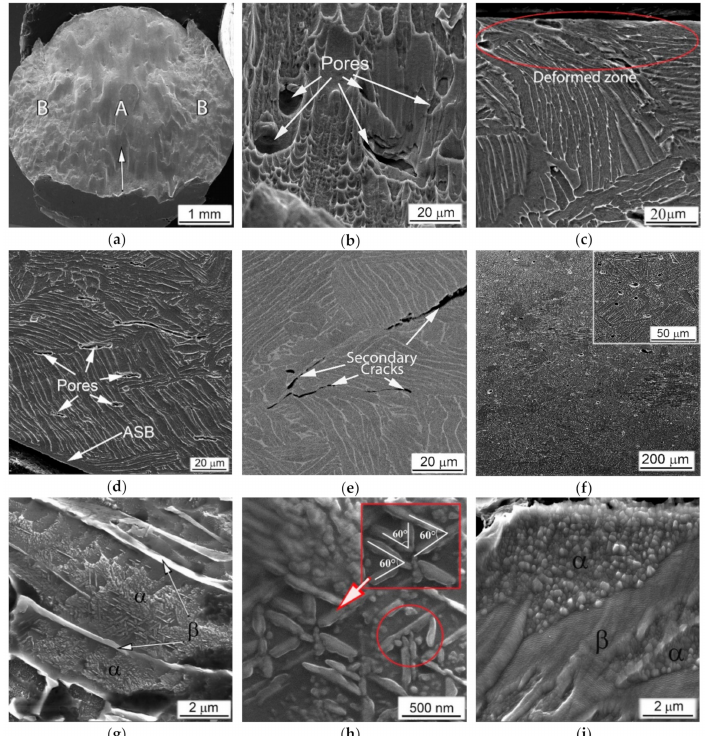
Figure 18. The SEM images of the fracture surface of the Ti64BEPM specimen tested at the strain rate of 2220 s − 1 : ( a ); general view; ( b ) residual pores at fracture surface; ( c – i ) internal microstructure; ( c ) zone I, ( d ) zone II; ( e , f ) zone III; ( g – i ) zone IV; (the arrow in ( a ): indicates direction of the crack growth from nucleation site; (A) and (B) label the fields of main and secondary cracks propagation, respectively). ( a – e , g – i ) SE; ( f )